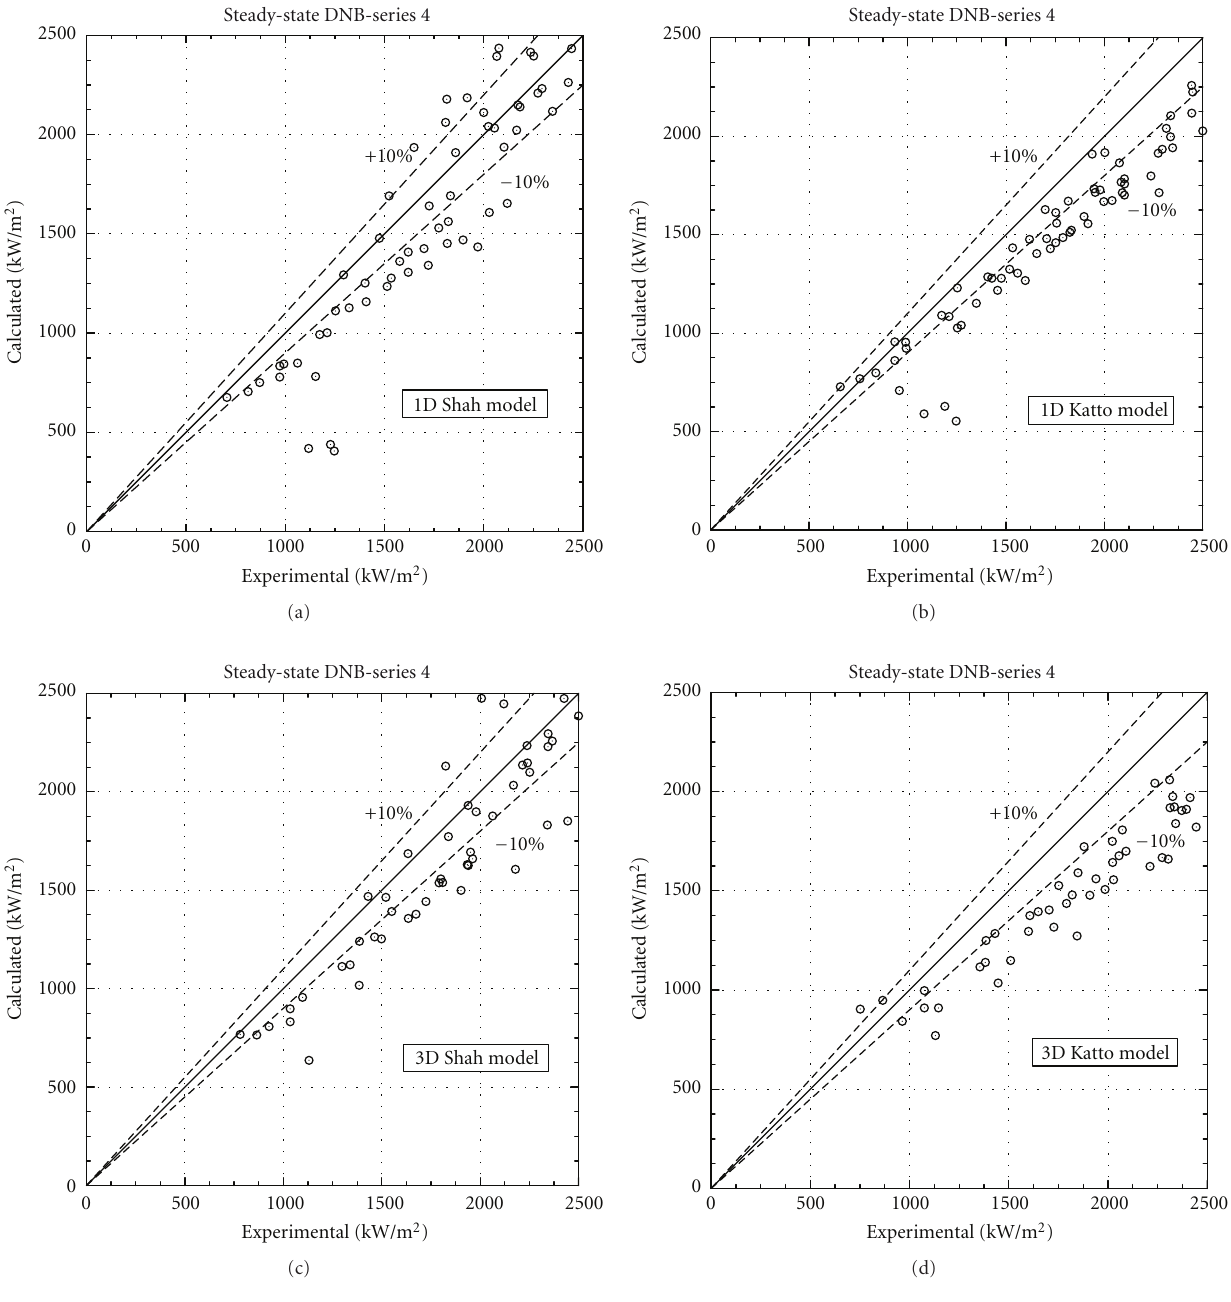
Figure 10: Computed versus experimental critical heat fluxes (Series